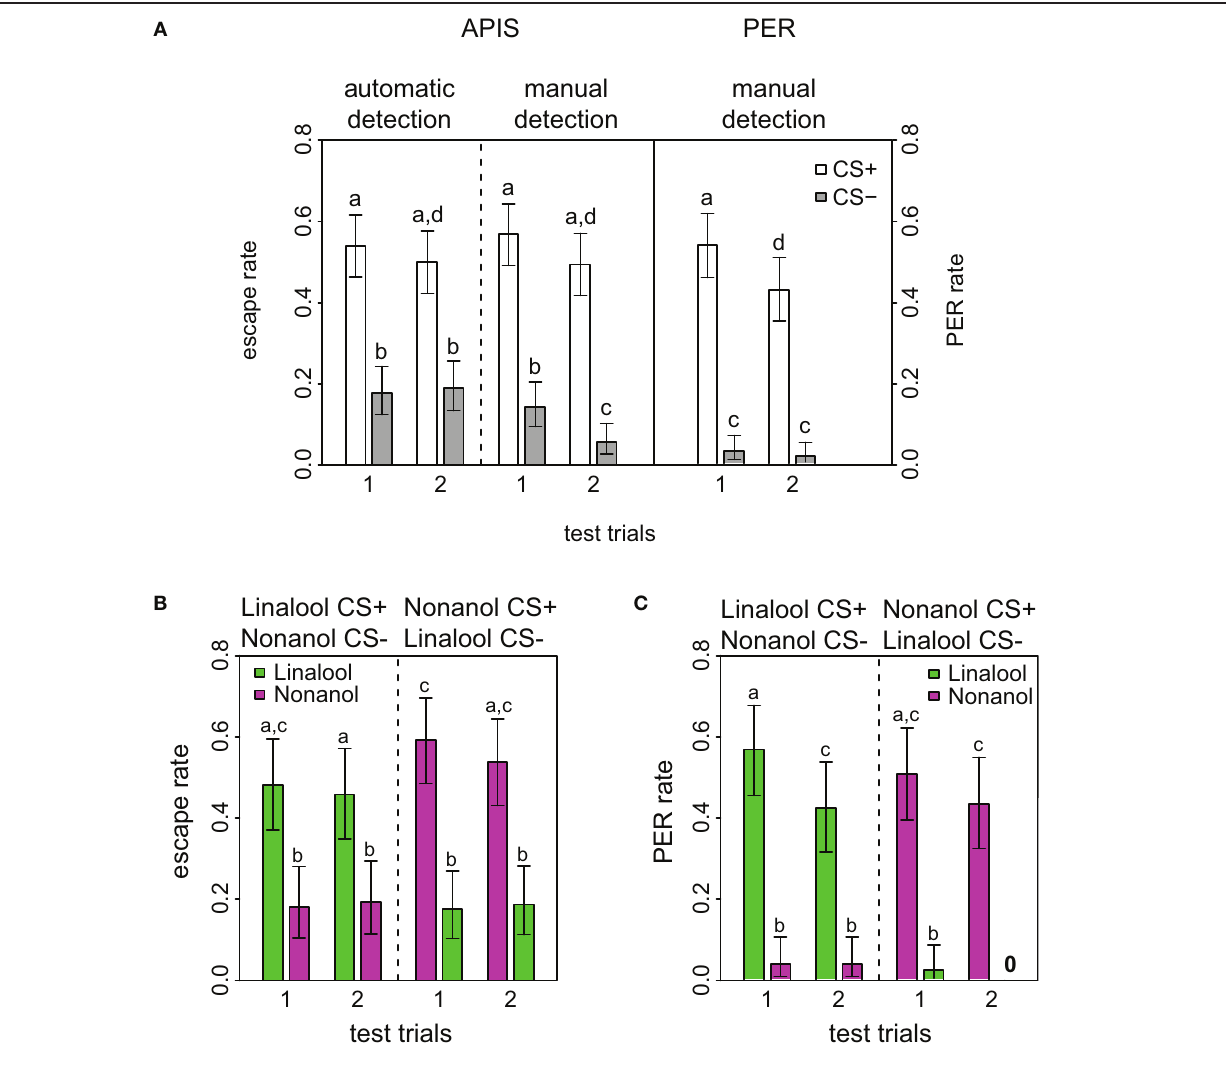
from APIS to the two odors linalool (green) and nonanol (magenta) during the four test trials of the recall phase. Left part of the plot contains the trials for the bees that experienced linalool as CS + and nonanol as CS − , whereas the right side contains the trials for the bees that experienced nonanol as CS + and linalool as CS − ( N = 83 and N = 91, respectively). Response rates are higher for nonanol as CS + , while generalization is equal in both cases. (C) Directly observed responses from PER to the two odors during the four test trials of the recall phase ( N = 82 in each group that received linalool or nonanol as CS + ). Note the very low generalization for both groups, and the prominent extinction for